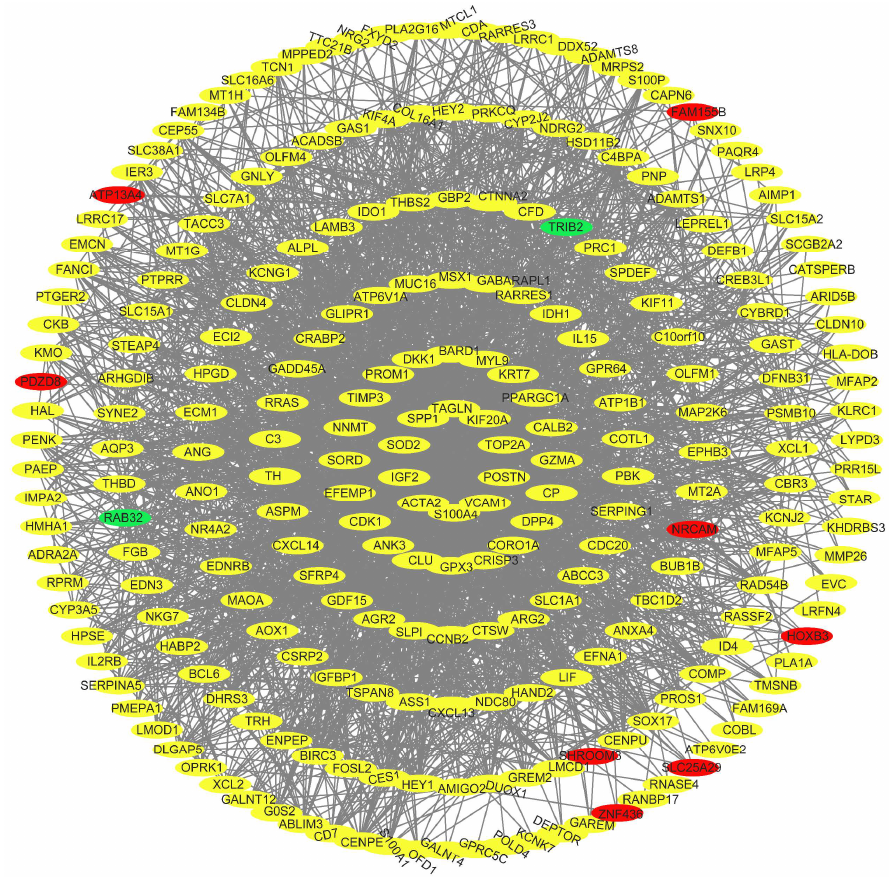
Figure 7. Protein–protein interaction network. Ten hub genes as potential RIF biomarkers interacted with ERA genes.